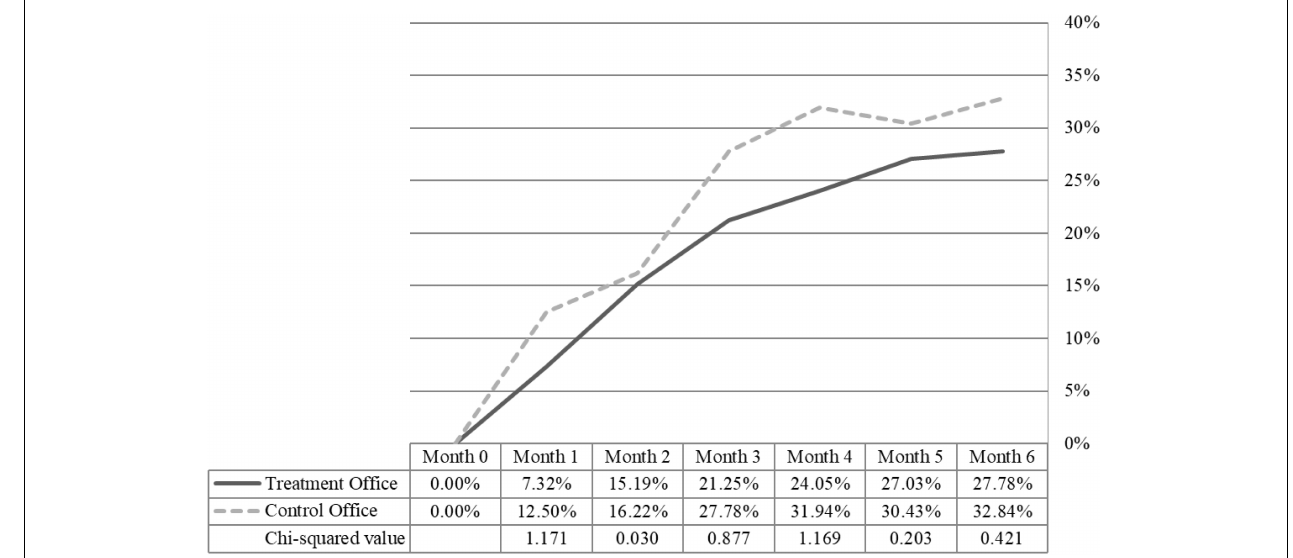
FIGURE 1 | Cumulative rates of reoffending